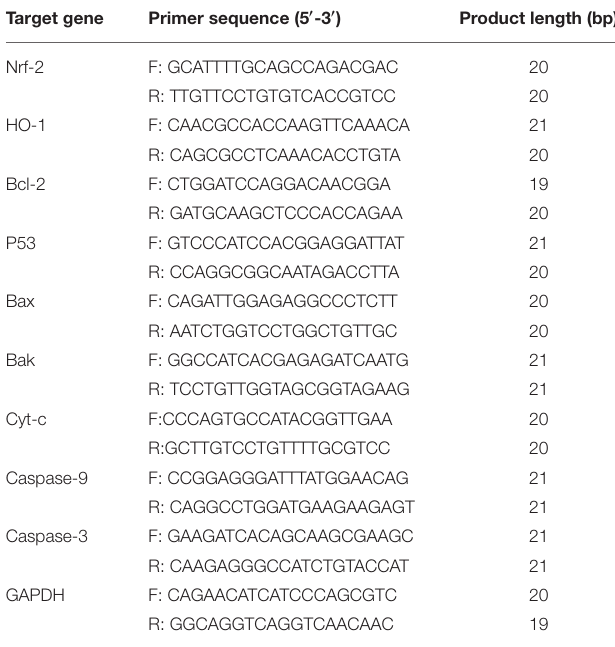
TABLE 1 | Primers for quantitative real-time